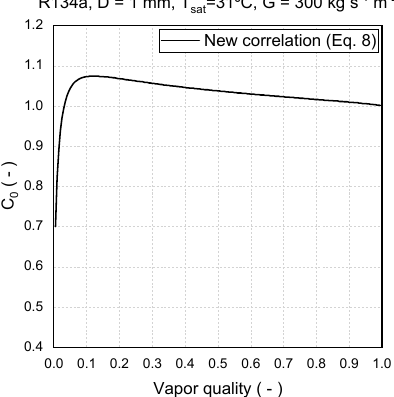
Fluids 2020 , 5 , x FOR PEER REVIEW 23 of 28 Figure 11. Distribution parameter in function of the quality. Figure 11. Distribution parameter in function of the quality.